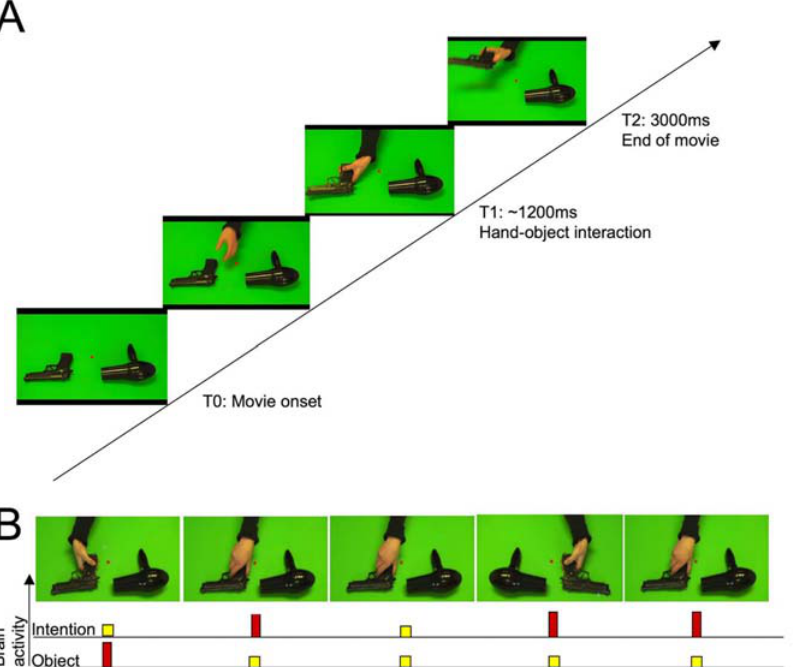
Figure 1. Stimulus sequence and paradigm. A. Sequence of stimuli presentation . Every trial consisted of the following sequence: T0: movie onset, T1: hand-object interaction followed by T2: end of movie. The example reported here represents a sample of an agent grasping a gun to use it. Task instruction was the following: ‘‘In this experiment, you will be asked to look at a centred red square during the entire session while trying to guess the intention of the actor in every video clip once the hand encounters the object (e.g., to use the object or to transport it).’’ B. Repetition suppression paradigm. Stimuli were presented in a mixed event-related/block design, with repetition suppression (RS) effects of intention (to transport vs. to use) and object (gun vs. hairdryer) examined within blocks. The example reported here represents a sample of an RS effect (in yellow for suppression and red for activation) that may occur on object goal (i.e., the use or WHAT) or action goal (i.e., the intention or WHY).